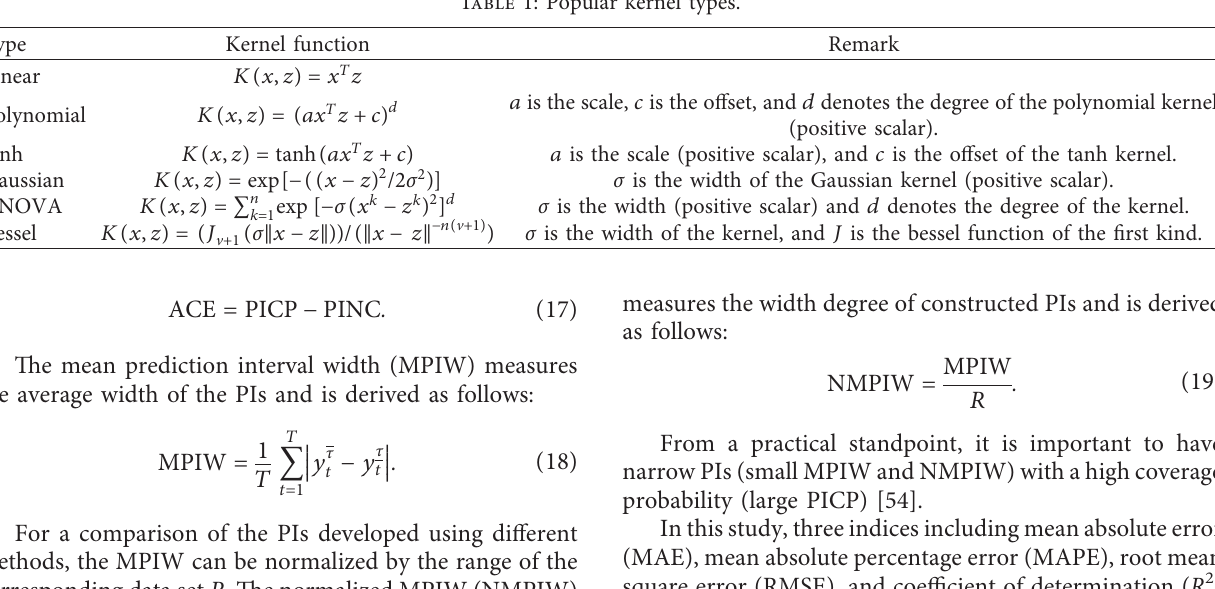
Figure 2: Nonlinear SVM regression with the ε -insensitive loss function. Table 1: Popular kernel